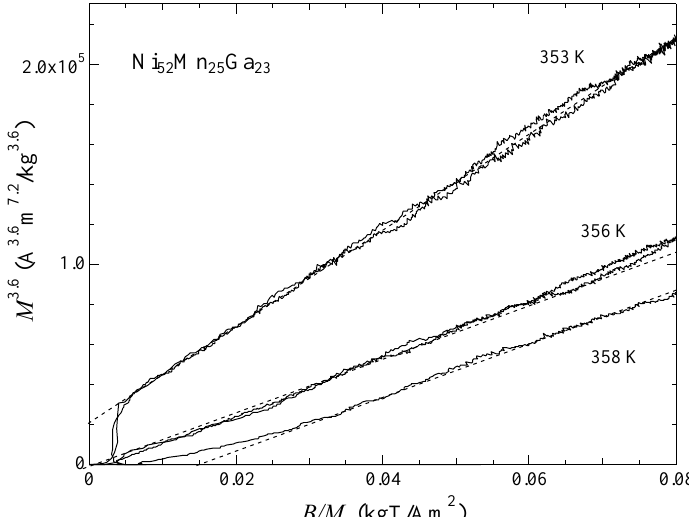
Mn Ga Dotted straight lines are extrapolated 52 25 23.